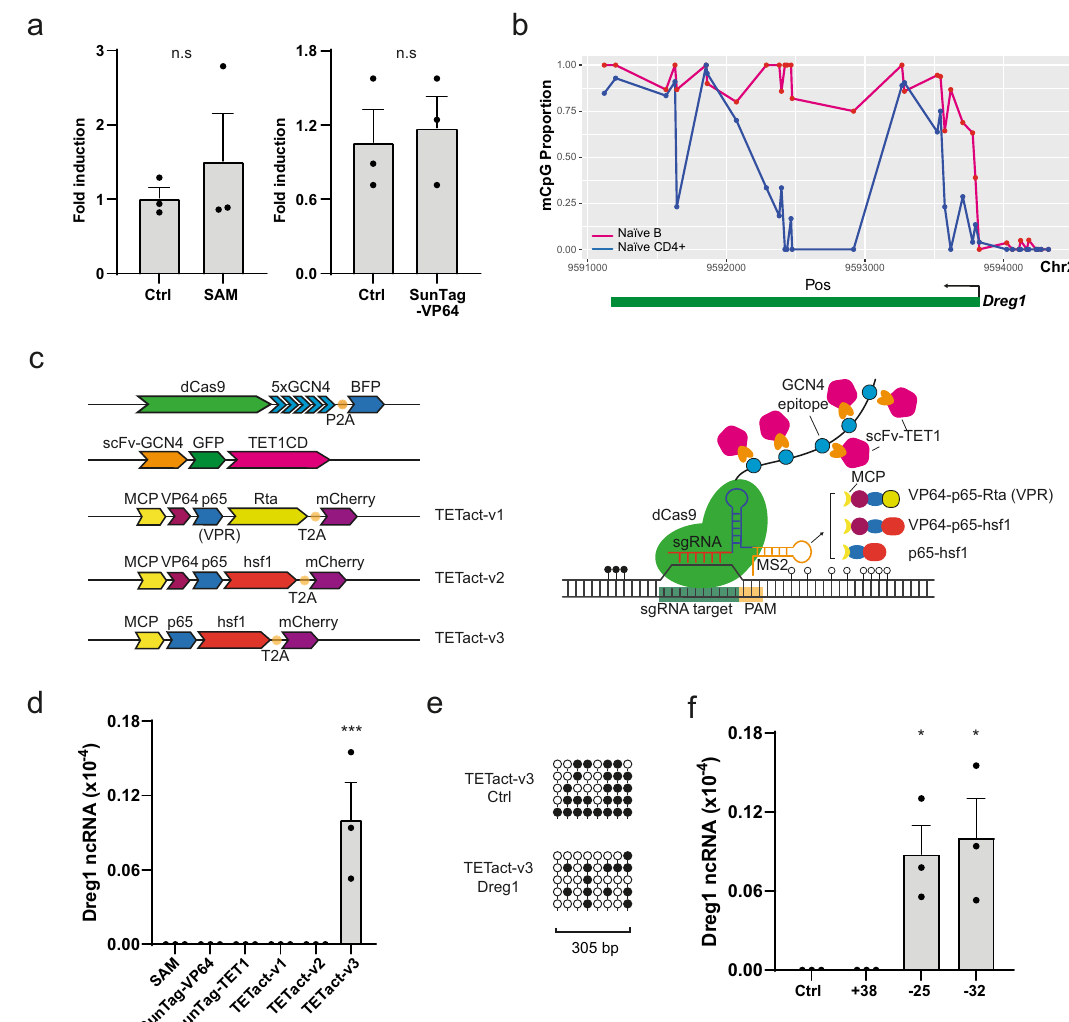
Fig. 1 | Activation of the T-cell speci fi c lncRNA Dreg1 in A20 B cells. a Fold activation of Dreg1 in A20 cells transduced with sgRNA targeting Dreg1 promoter together with SAM or SunTag-VP64 constructs. Fold change is calculated by ΔΔ Ct method. Data were analysed with unpaired two-sided Student ’ s t -test compared to control b DNAmethylation(mCpG)pro fi lesofnaïveBandCD4+Tcellsatthe Dreg1 locus, plotted as population proportion of methylated cytosine in each CpG dinucleotide motif. c Schematics of TETact systems and corresponding construct designs — multiple copies of TET1CD are recruited to dCas9 via the GNC4 epitopes, whereas the activator domains (v1 — VPR, v2 — VP64-p65-hsf1, v3 — p65-hsf1) are